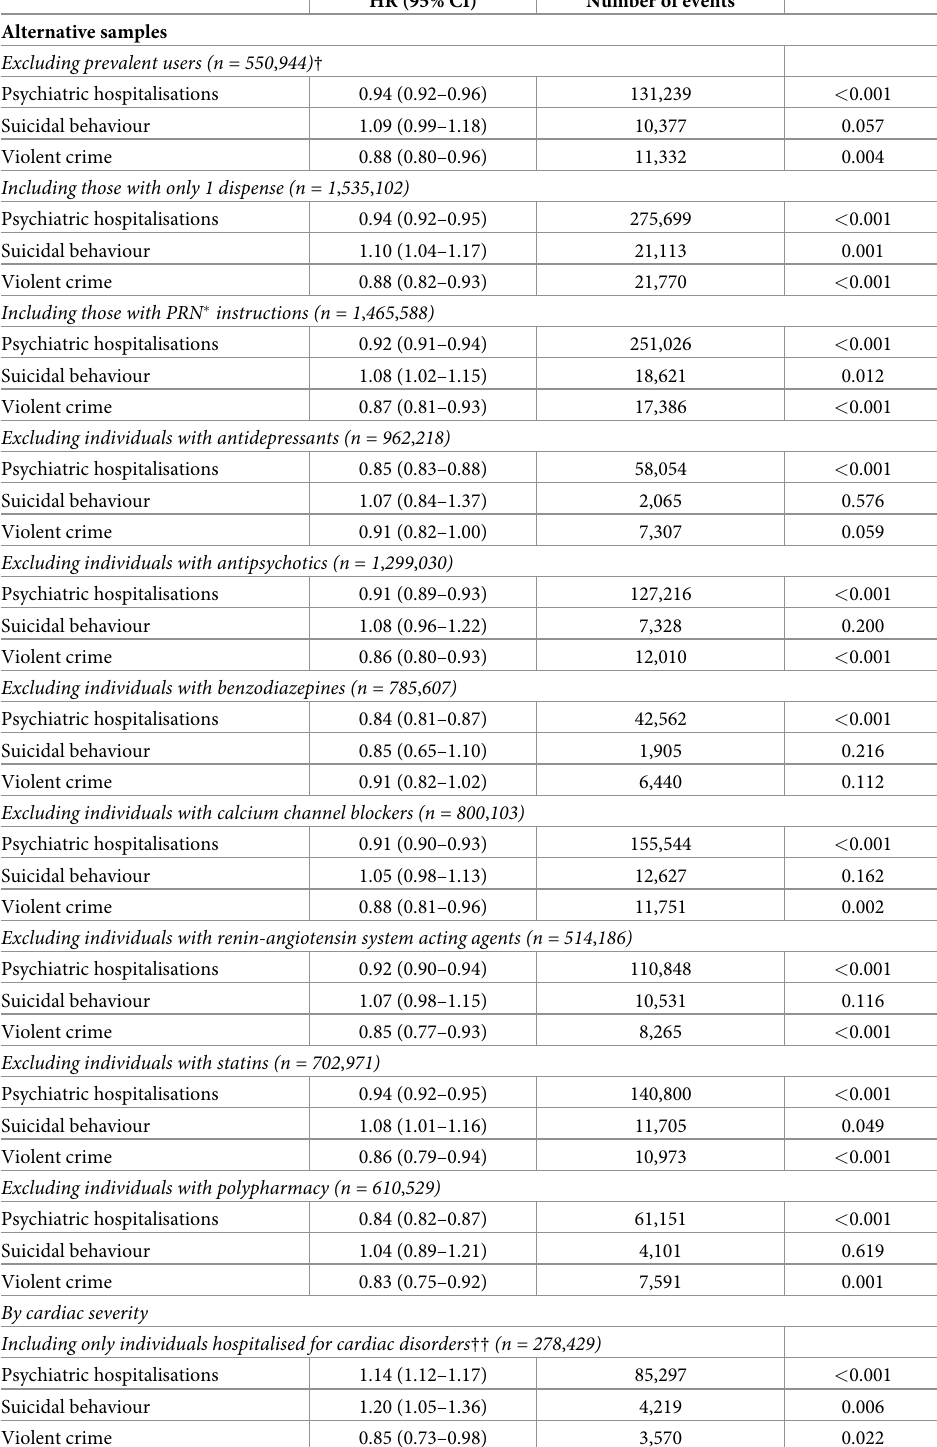
Table 3. Sensitivity analyses; age-adjusted within-individual associations between β -blockers and psychiatric and behavioural outcomes using alternative